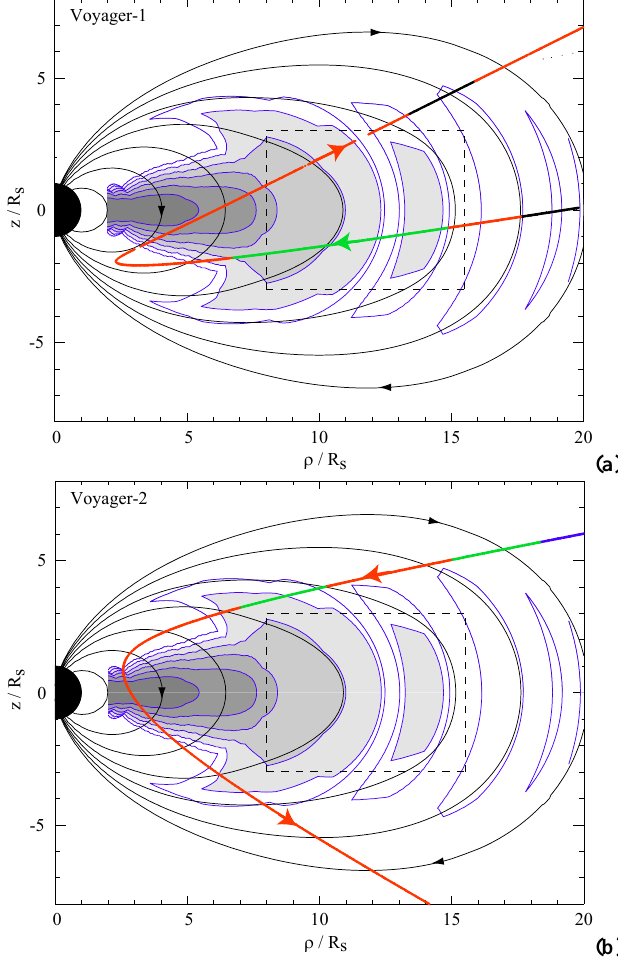
Fig. 4. Plots showing the colour-coded trajectories of (a) Voyager-1 and (b) Voyager-2, plotted in the (ρ,z) plane. The colour coding is the same as in Fig. 3. The black solid lines show magnetic field lines determined from the SPV internal field model plus Conner- ney et al. (1983) ring current (black lines). The dashed lines show the cross section of the model ring-current region. The solid blue lines show contours of the heavy-ion (O + ) density determined from the model of Richardson and Sittler (1990) and Richardson (1995), based on Voyager PLS plasma data. The innermost contour on the left of the diagram corresponds to an ion density of 30cm − 3 (with model values between 100 and 30cm − 3 being shown dark grey), with subsequent contours corresponding to densities of 10, 3, 1, 0.3, and 0.1cm − 3 (with values below 0.3cm − 3 being shown